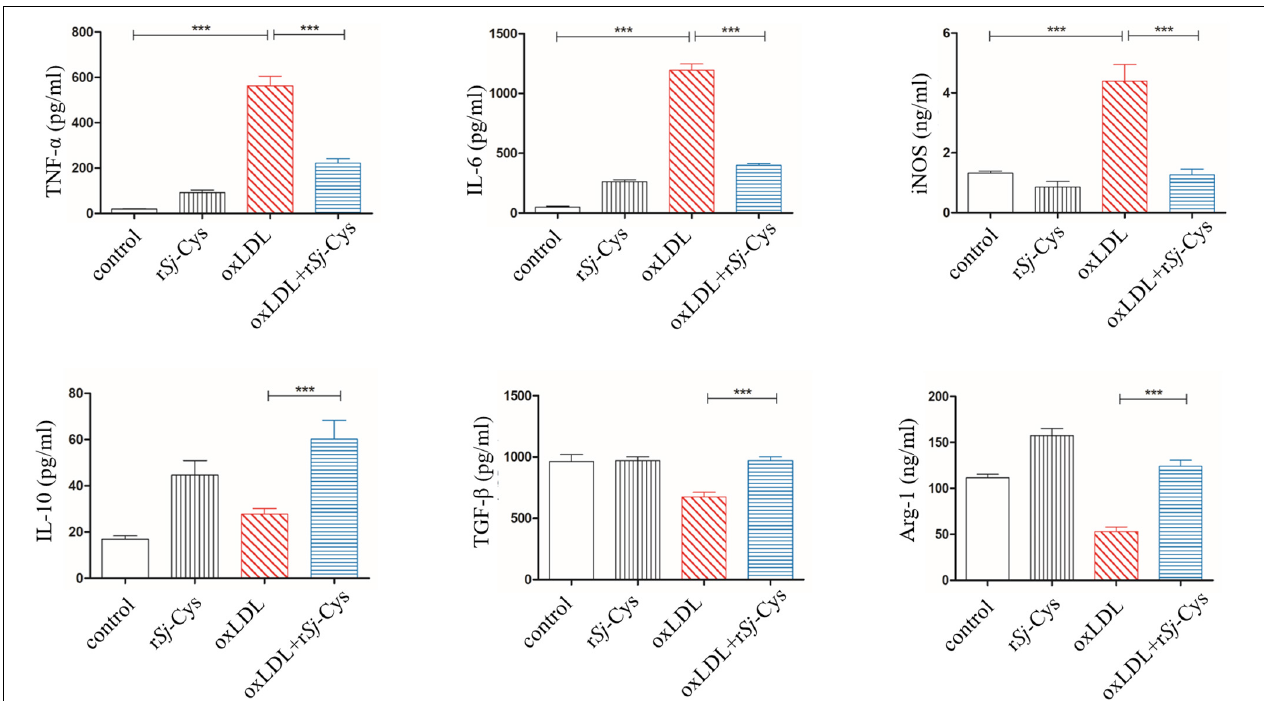
FIGURE 8 | r Sj -Cys down-regulated proinflammatory cytokines (TNF- α , IL-6) and iNOS and up-regulated immunomodulatory cytokines (IL-10, TGF- β ) and Arg-1 from murine peritoneal macrophages stimulated by oxLDL. The levels of these cytokines/enzymes in the culture supernatants were detected by ELISA 24 h after incubation. The results are shown as the mean ± SEM for each group ( n = 6 per group). *** P <